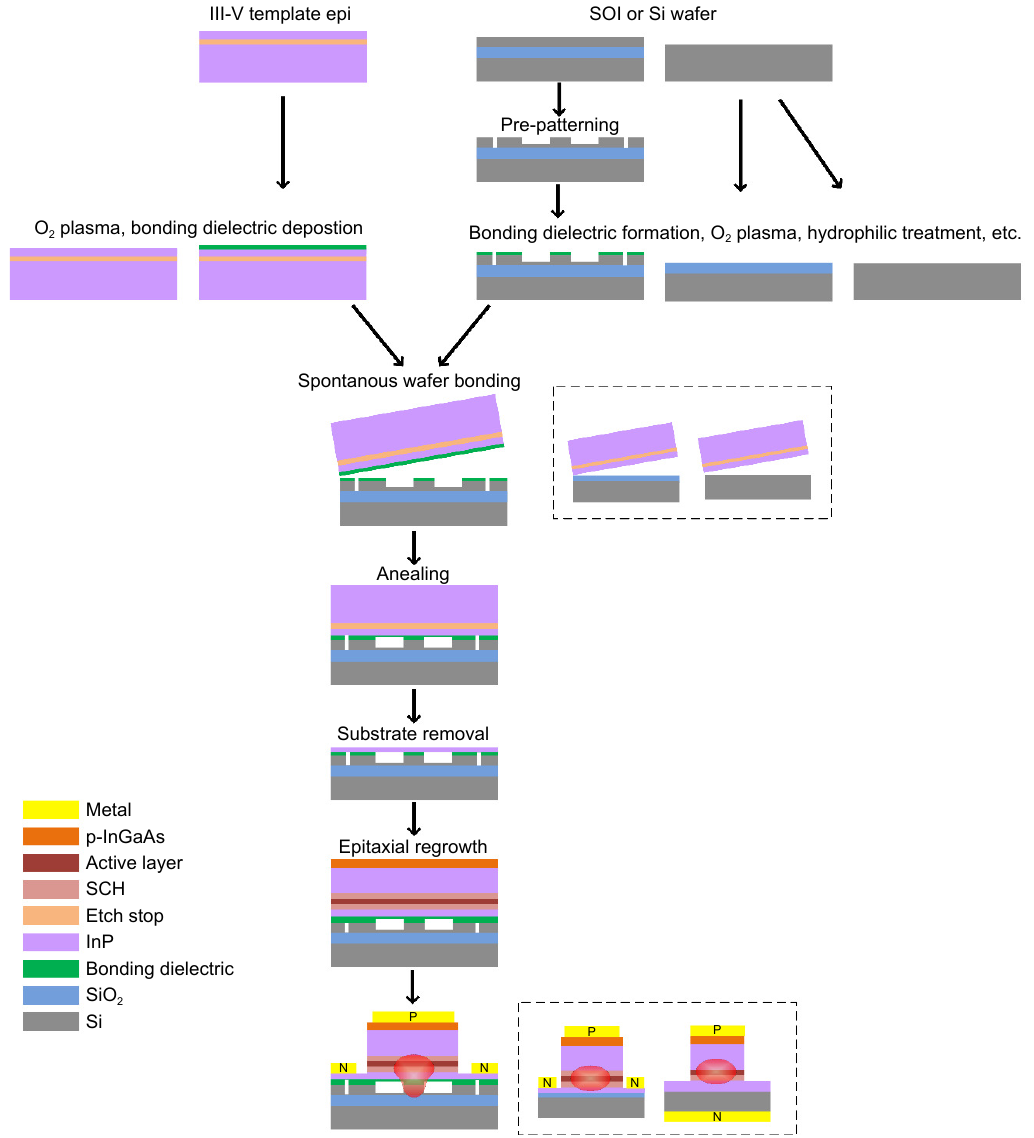
Fig. 1 | A schematic drawing of the process flow for the advanced heterogeneous integration by using regrowth on III-V-on-Si bonding